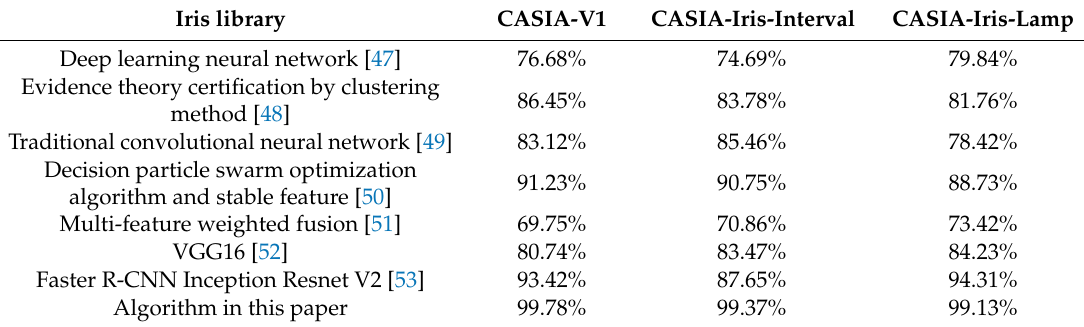
Table 9. The CRR of the three iris libraries compared to the existing